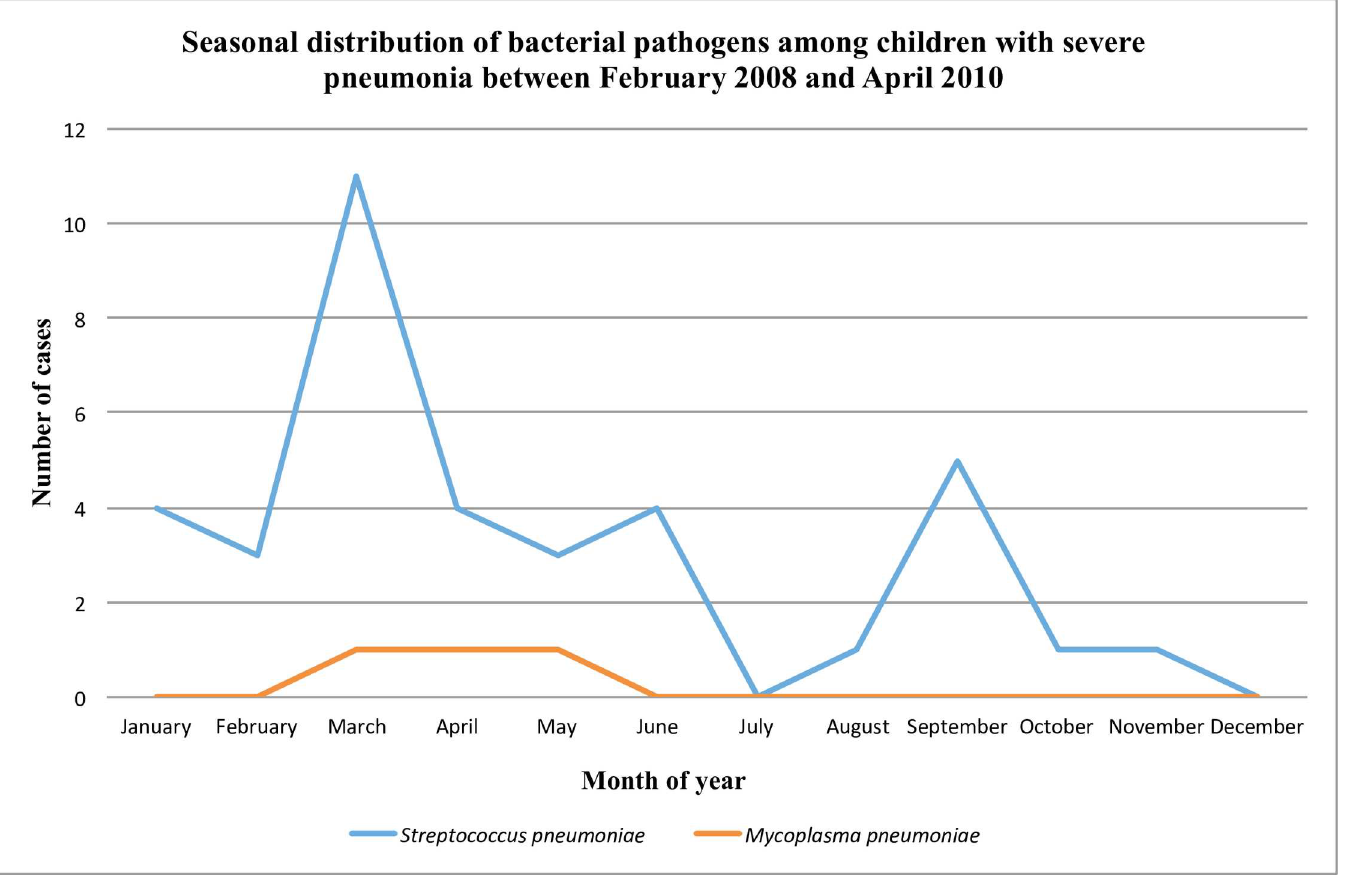
Fig 3. Seasonal distribution of bacterial pathogens among children with severepneumonia between February 2008 and April